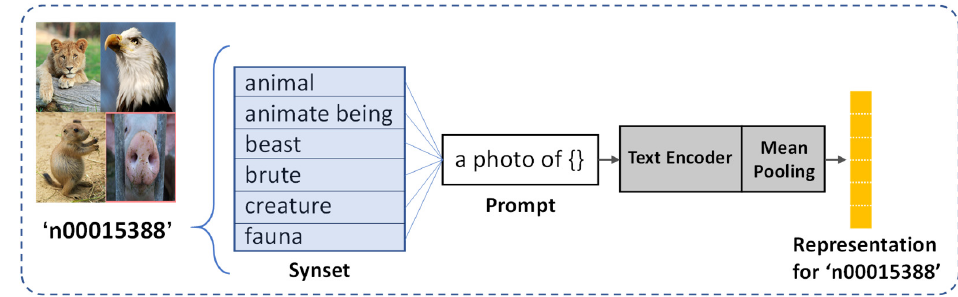
Figure 4. An illustration for generating the representation of class ‘n00015338 ′ in ImageNet21K, which is a wnid concept consisting of 6 synonyms.